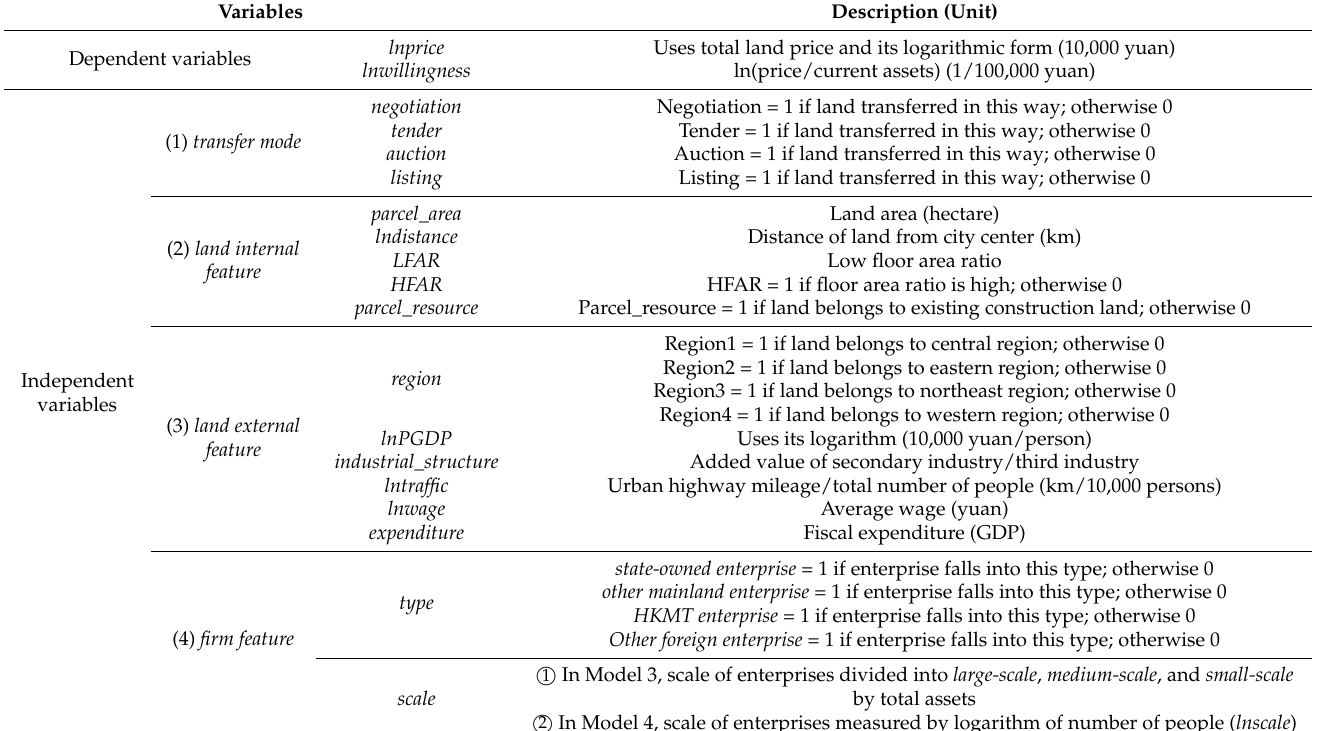
Table 2. Variable